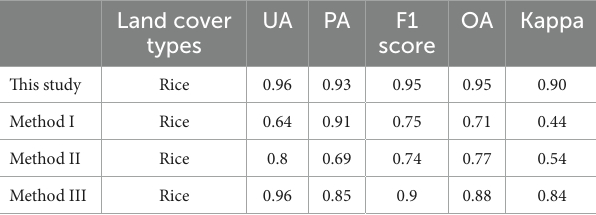
TABLE 5 The comparison of rice mapping performances of the four